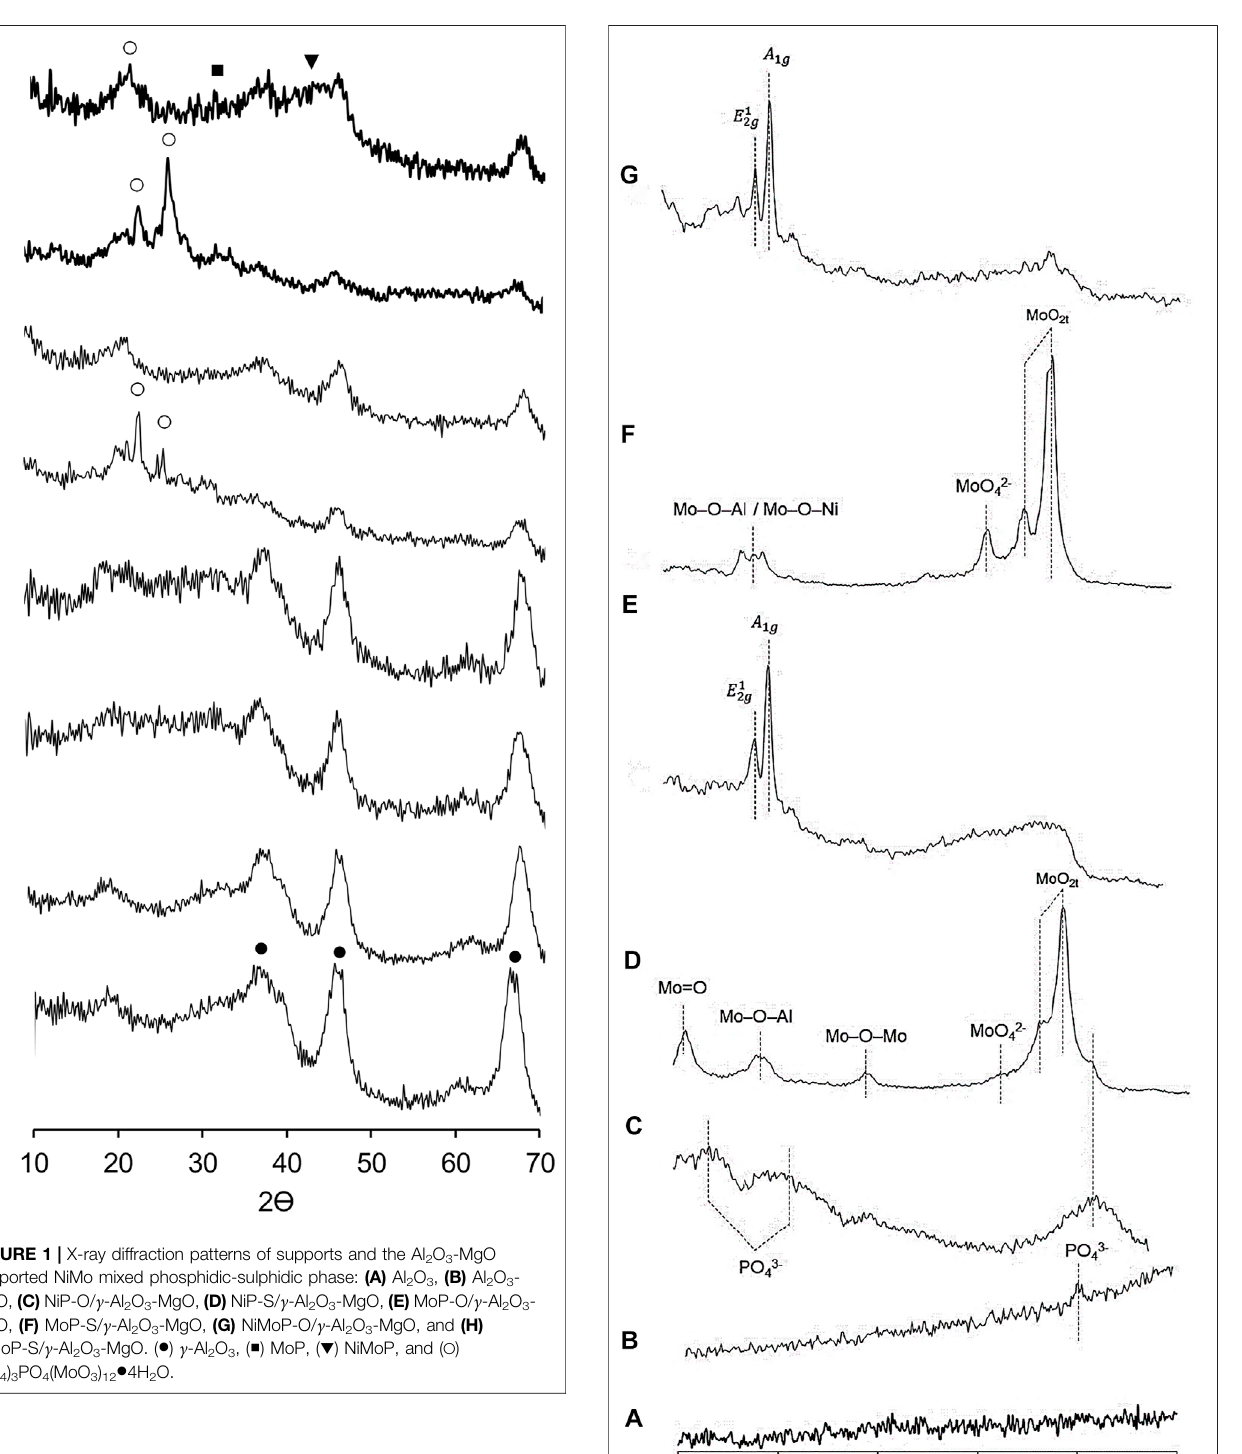
Frontiers in Chemistry |